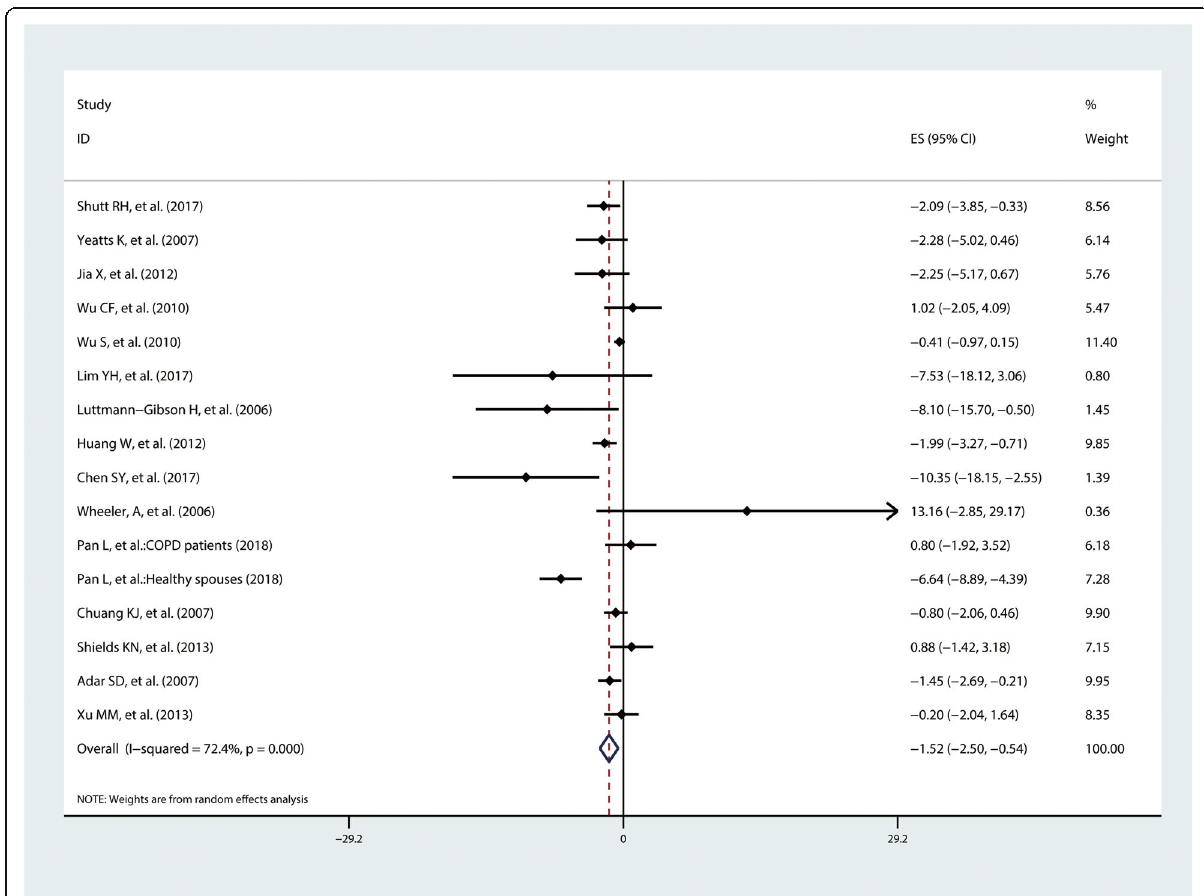
Fig. 5 Pooled percent change (%) of LF associated with a 10 μ g/m 3 increase to PM